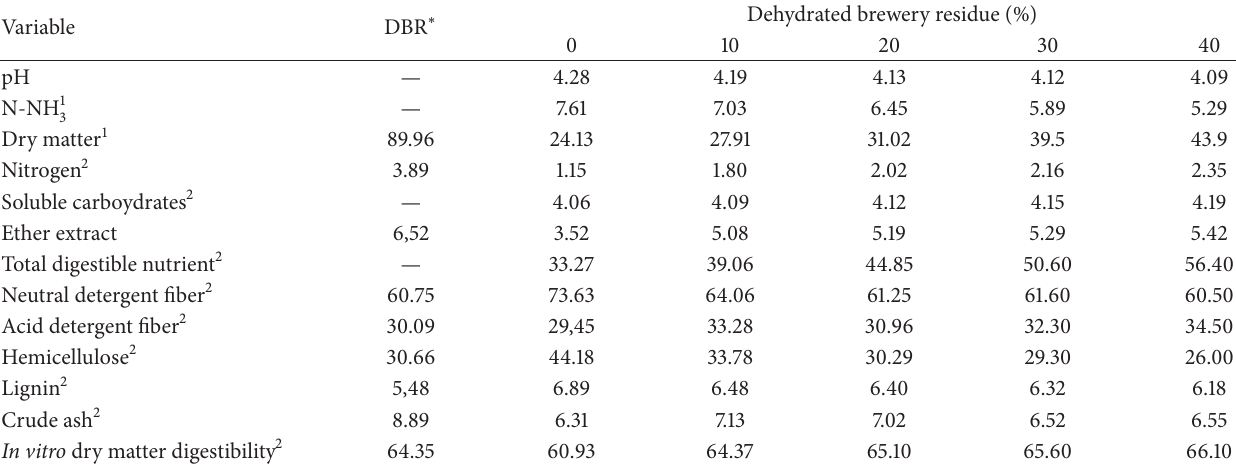
Table 1: Chemical composition, pH, and N-NH 3 of marandu grass silage with dehydrated brewery residue added.